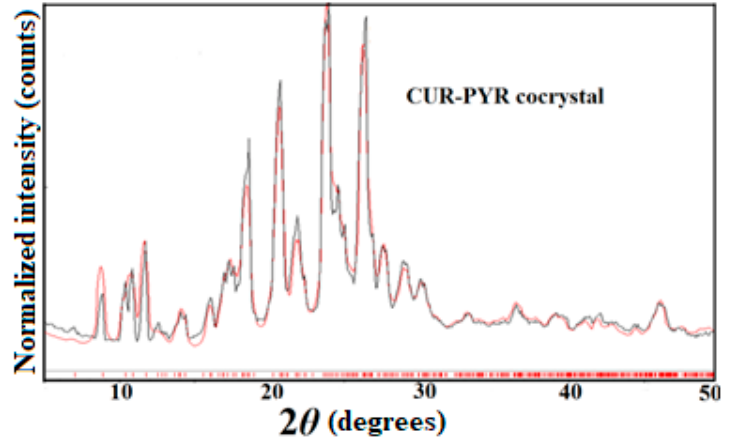
Figure 2. Experimental PXRD (black trace) of CUR-PYR match nicely with the calculated X-ray diffraction lines from the crystal structure (red), indicating the excellent purity of the bulk phase [27].